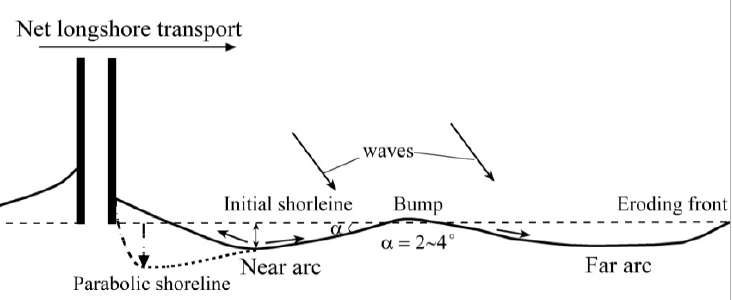
Figure 12. Illustration of the downdrift shoreline erosion arc planform of Bruun [1] ( Reproduced and modified with permission from the Coastal Education and Research Foundation, Inc. ) compared to a parabolic shoreline shape.